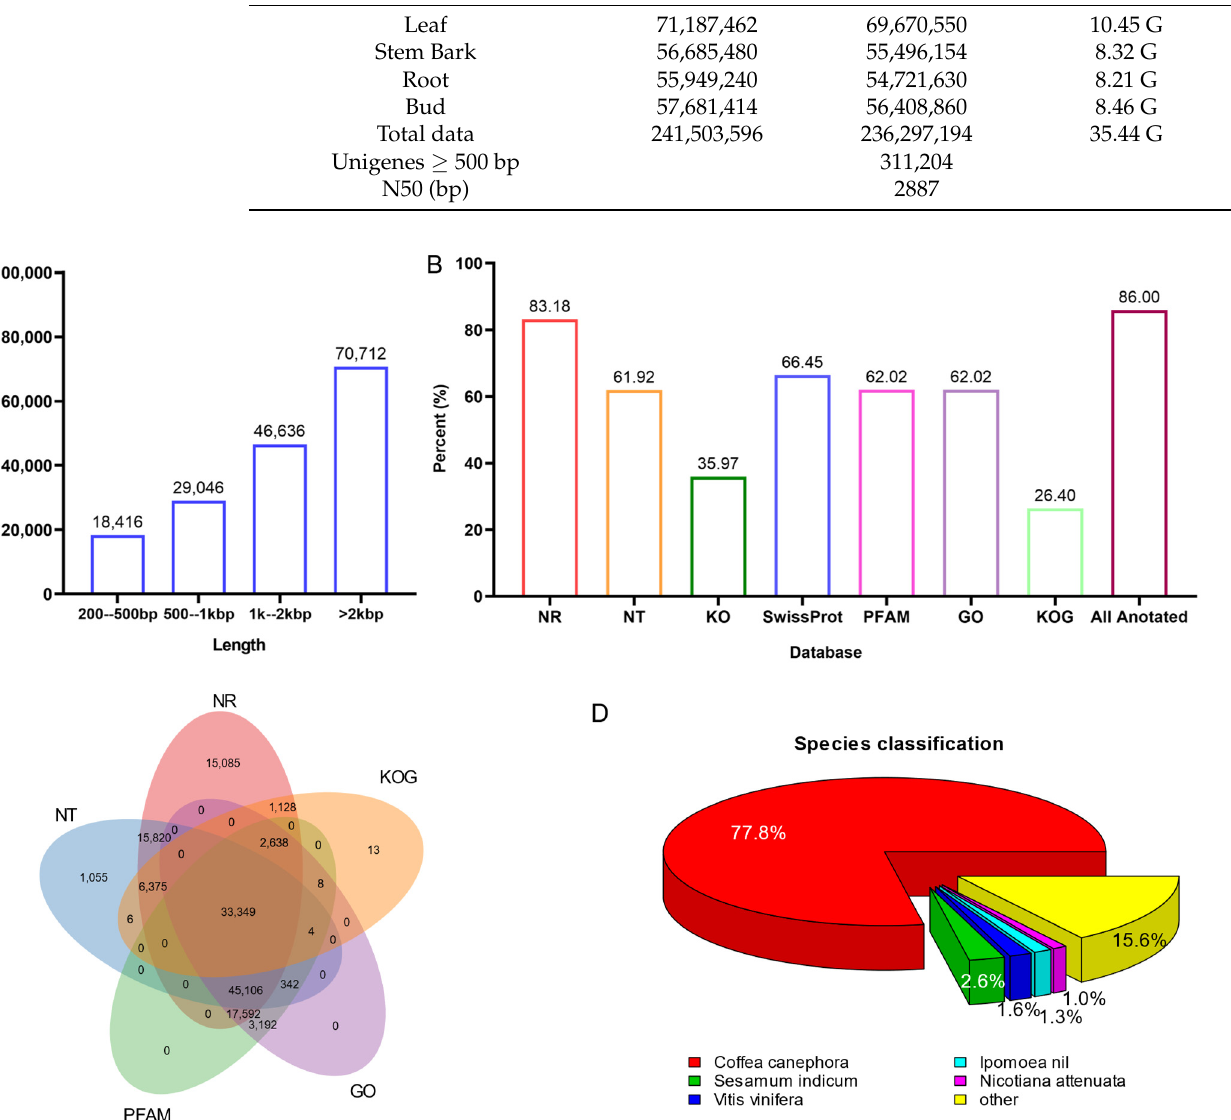
Table 1. Overview of the sequencing and assembly of transcriptome of U. rhynchophylla . Items RAW READS